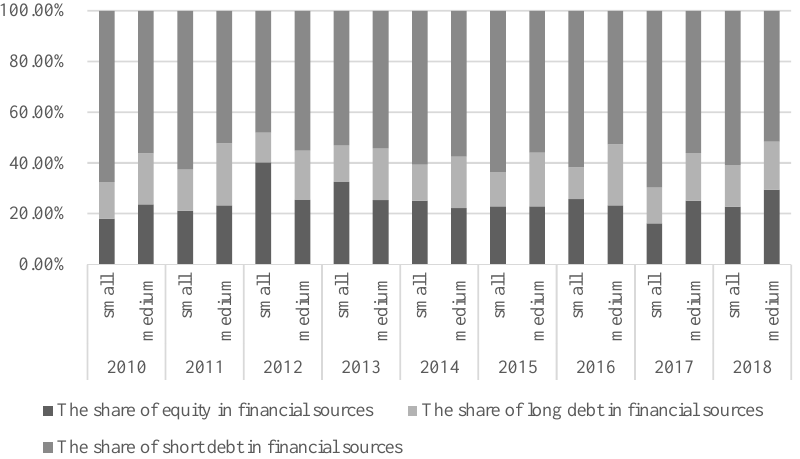
Figure 1. Capital structure of Russian manufacturing SMEs in years 2010–2018